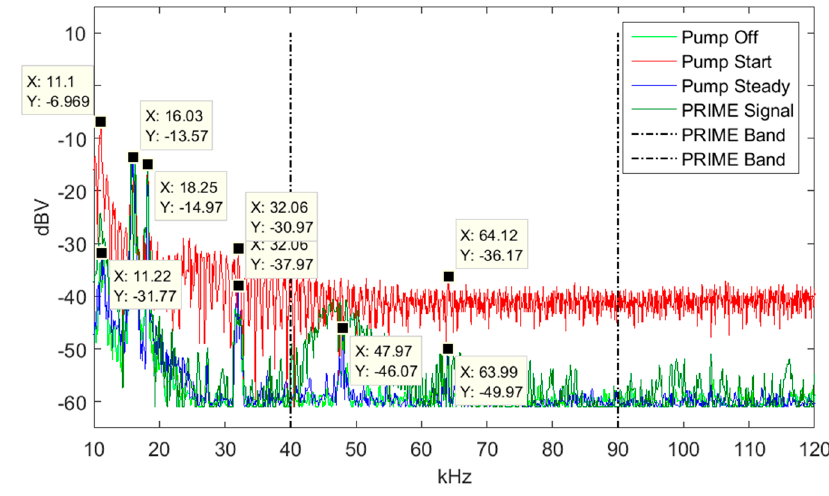
Figure 14. Spectrum recorded at the pump SM with the rest of surrounding devices connected.